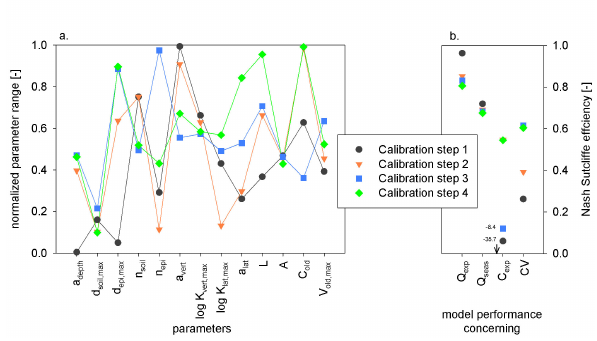
Fig. 4. (a) Normalized optimized parameter sets for the four cali- bration steps and (b) the resulting NS